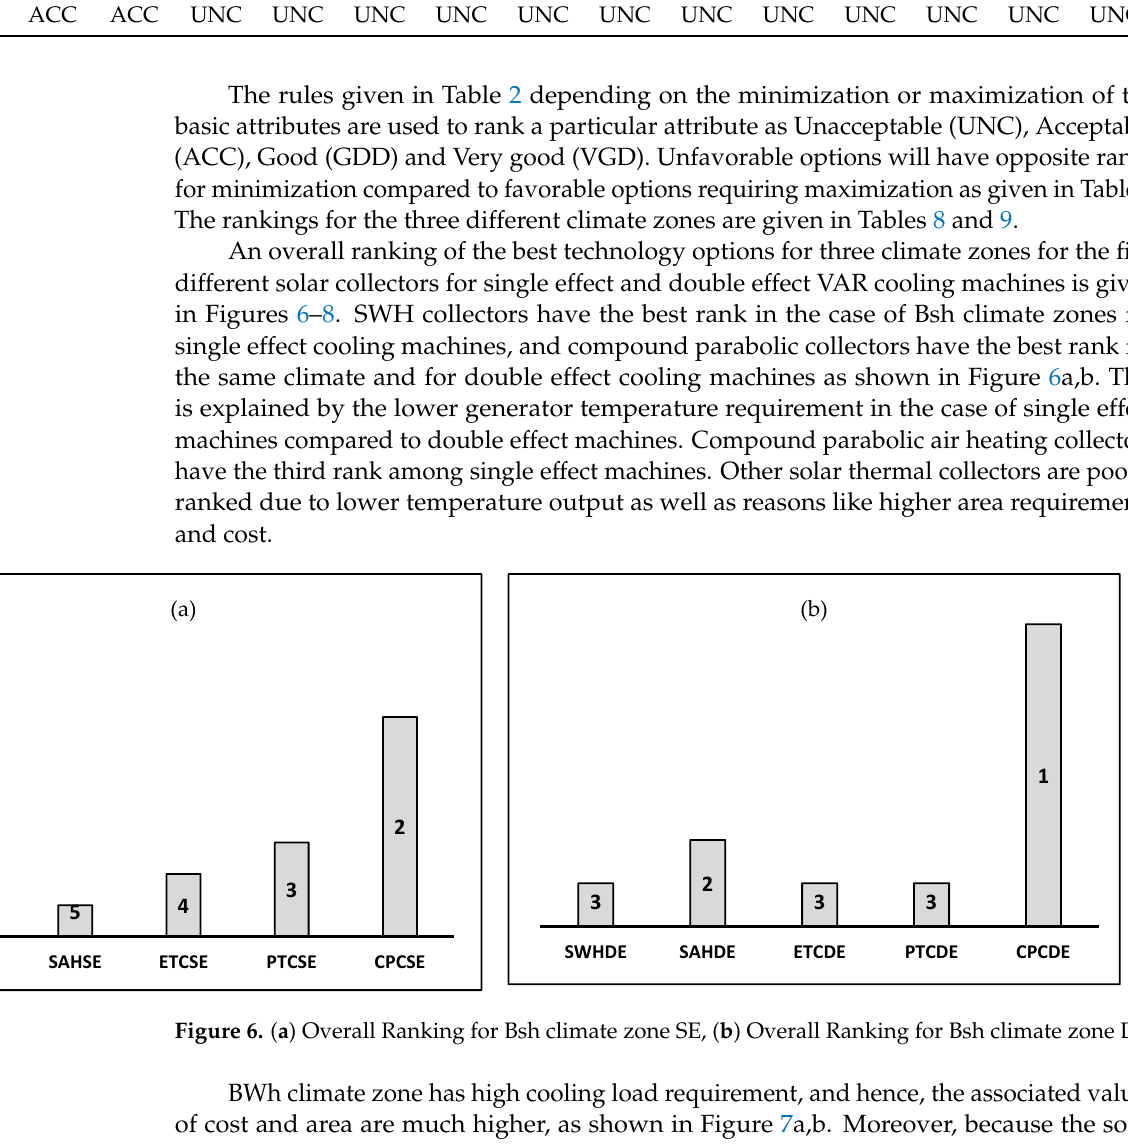
Figure 7. ( a ) Overall Ranking for BWh weather scenario SE, ( b ) Overall Ranking for BWh weather scenario DE. In the case of Dwa weather zone, the cooling load requirement is much lower than the previous two zones, and the intensity of solar radiation received is much lesser throughout the year. Due to higher outlet temperatures of solar air heating compared to SWH, ordinary solar air heaters without concentration are able to meet the temperature and energy requirements for cooling in this zone, as in Figure 8a. The lower cost of these systems also work favorable to this concept. However, in the case of double effect cooling machines in Figure 8b, the required temperature can be met only by concentrating type solar air heaters. This is due to lower average solar radiation in this climate zone.